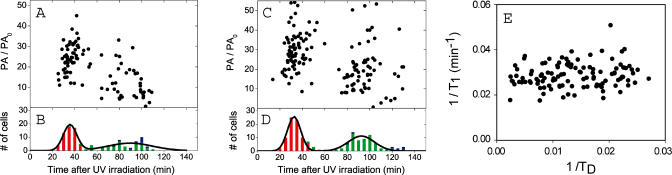
Effects of the umuDC Operon on the Temporal Modulation of Promoter Activity(A) Peak PA of the recA promoter as a function of peak time for individual ΔumuDC cells and (B) its corresponding histogram of the peak times. The amplitude and timing of the first peak are more correlated (correlation coefficient = 0.37, p = 0.002) than in wild-type cells (Figure 2A, correlation coefficient = 0.18, p = 0.13). (C) Peak PA of the recA promoter as a function of peak time for individual AB1157 cells transformed with a noncleavable umuD mutant gene (K97A) expressed from a plasmid, and (D) its corresponding histogram of the peak times. The experiments were carried out at 20 J/m2. (E) Scatter plot of 1/T
1 as a function of the growth rate, 1/TD, of individual ΔumuDC cells irrespective of UV dose. In contrast with wild-type behavior (see Figure 3B), experiments with ΔumuDC mutants show that the timing of first peak maxima and cell growth rate 1/TD are poorly correlated (correlation coefficient = 0.15, p = 0.06, compared with a correlation coefficient = 0.66, p < 10–4 measured for AB1157 cells).